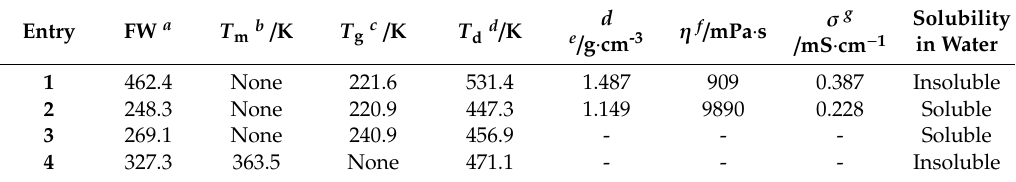
a Formula weight. b Melting point. c Glass-transition point. d Thermal degradation temperature at 1 wt % loss. e Density. f Viscosity. g Ionic conductivity at 303